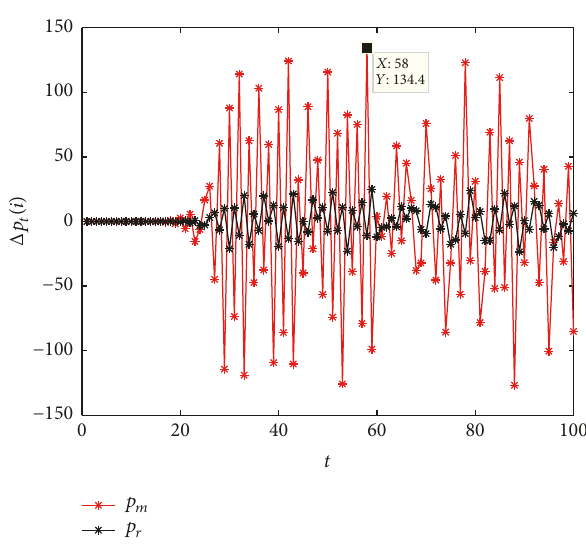
Figure 6: Sensitivity dependence to initial conditions with ( 𝑝 𝑟 ,𝑝 𝑚 ) = (180.277, 151.455) and (180.277, 151.4551).